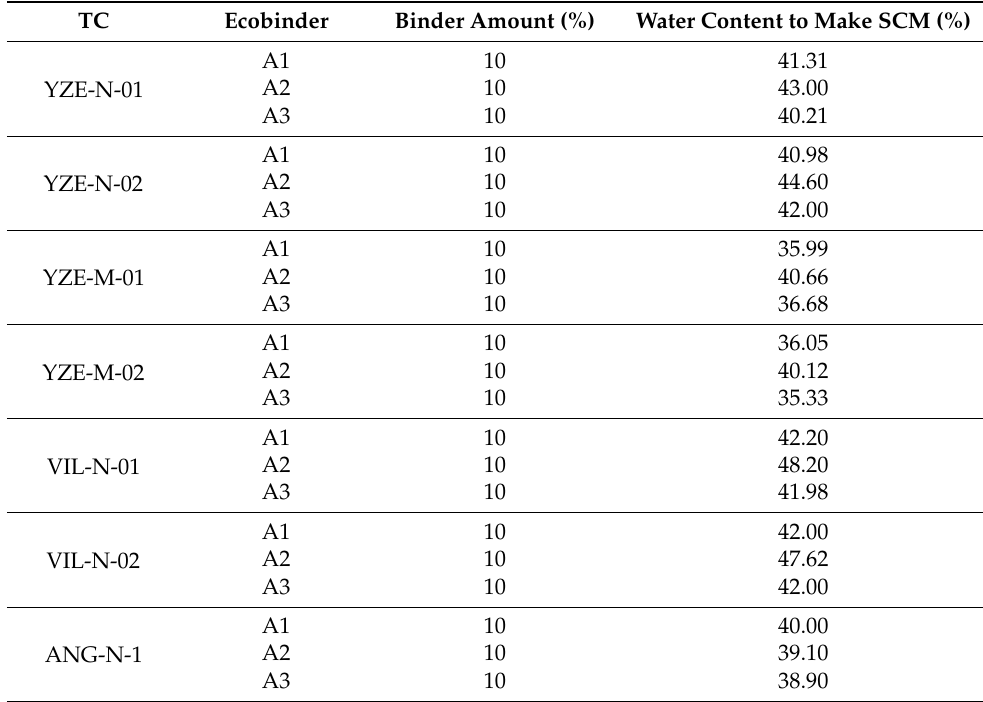
Table 7. Amount of water needed to make each mixture a